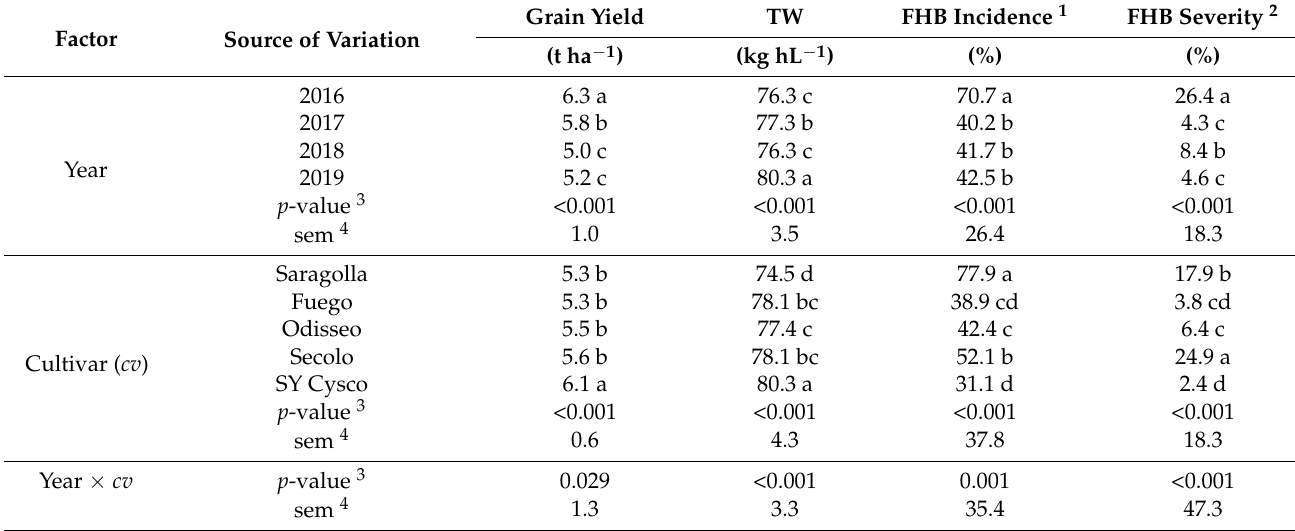
Table 4. Effects of the growing season and durum wheat cultivar, with different degrees of FHB susceptibility, on the grain yield (Yield), test weight (TW), FHB incidence and severity in NW Italy during the 2015–2019